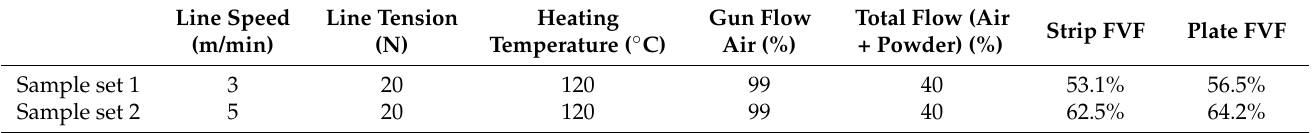
Figure 3. ( a ) Towpregs in the tensioning equipment (enclosed within the mould and not visible) and peel ply (orange). ( b ) Vacuum bagging of the tensioning equipment. ( c ) Cured composite plate and visible spots from absorbed resin by the peel ply (sample set 2 case). Table 1. FVF of the towpreg strips and composite plates at different processing